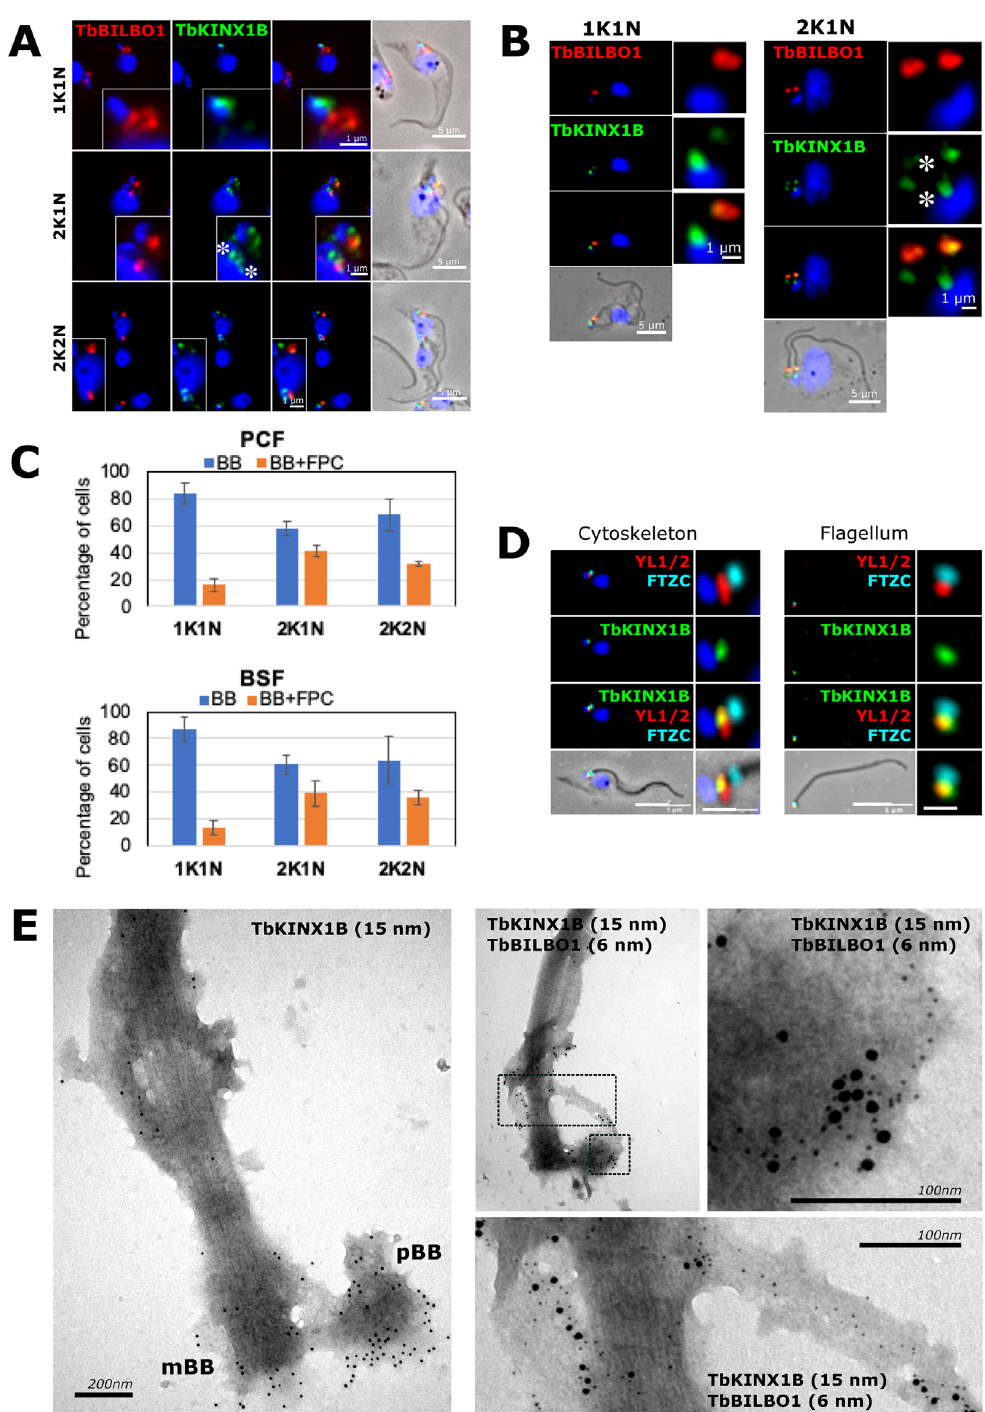
Figure 2. TbKINX1B displays a dual localization. A. Co-immunolabeling of TbKINX1B and TbBILBO1 on PCF detergent-extracted cells using anti-BILBO1 (red) and anti-TbKINX1B (green). B. Co-immunolabeling of TbKINX1B and BILBO1 on BSF detergent-extracted cells using anti-BILBO1 (red) and anti-TbKINX1B (green). C. Quanti fi cation of TbKINX1B BB and/BB+FPC localization in PCF and BSF from immuno fl uorescence experiments shown in A and B. BB localization (white bars) or BB and FPC localization (grey bars) were quanti fi ed at different cell cycle stages (200 cells, n = 3). D. Co-immunolabeling of TbKINX1B (green) and the basal bodies marker YL1/2 (red) and the transition zone marker FTZC (cyan) on detergent-extracted PCF cells cytoskeleton and fl agellum. E. Immuno-TEM using PCF isolated fl agella that were labelled with anti-TbKINX1B (15 nm gold particles), and co-immunolabeled with anti-TbKINX1B (15 nm gold) and anti- TbBILBO1 (6 nm gold). The images show positive labelling of the protein at the basal bodies (pBB, mBB), Flagellar Pocket Collar (FPC) and at the MTQ. The zoom image shows the TbBILBO1 6 nm gold beads on the MTQ and the colocalization of TbKINX1B and TbBILBO1. Scale bars in A, B and C represent 5 l m, and 1 l m in